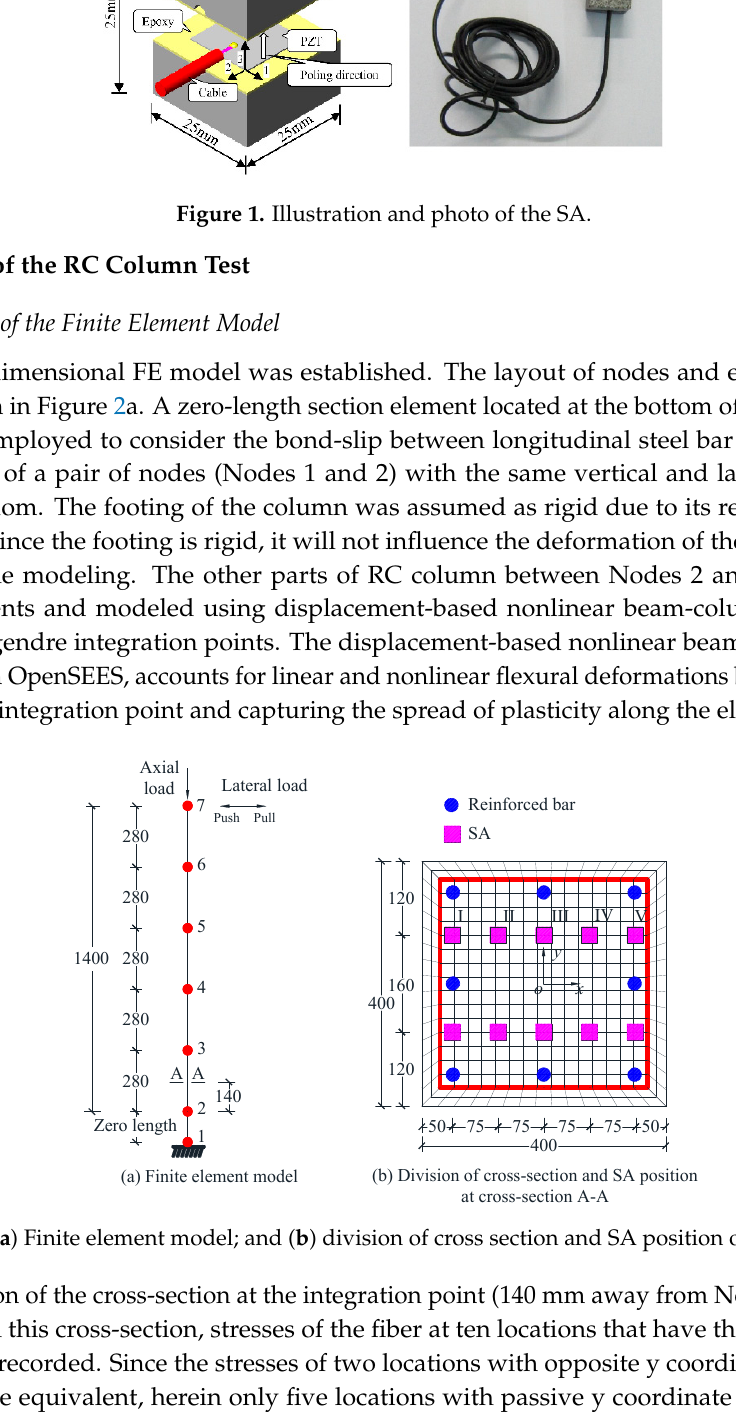
(b) Division of cross-section and SA position at cross-section A-A Figure 2. ( a ) Finite element model; and ( b ) division of cross section and SA position of RC column.